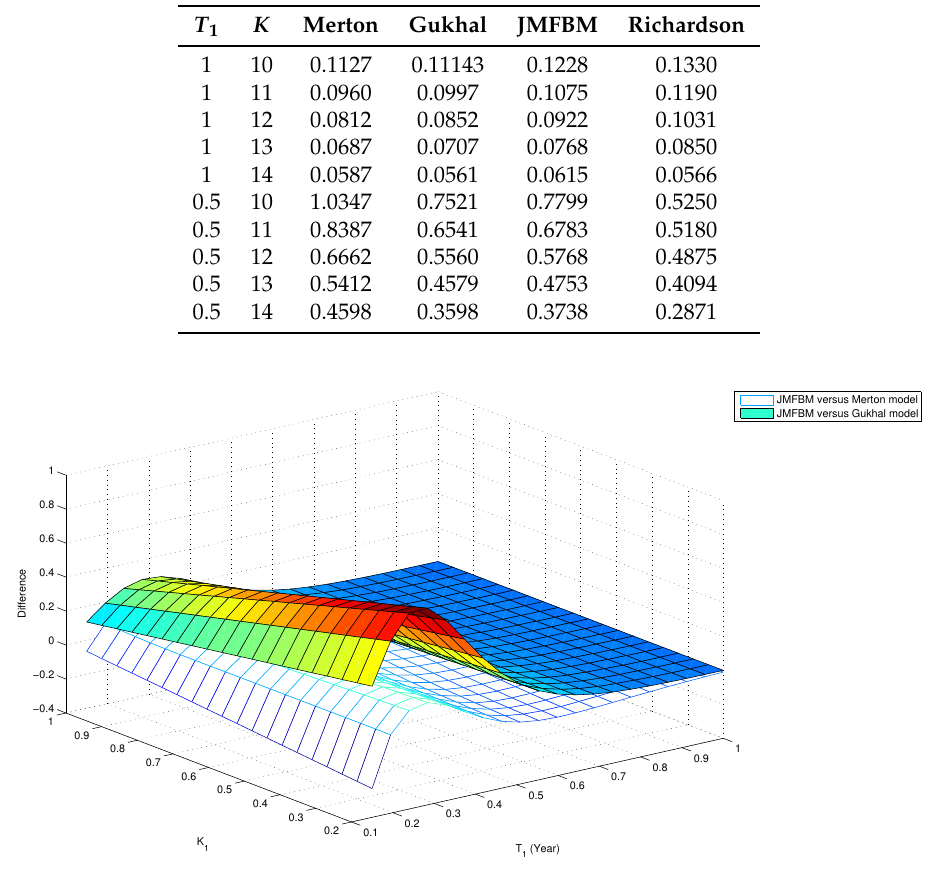
Figure 1. The relative difference between our JMFBM , Guukhal, and Merton models. Parameters fixed are r = 0.3, σ = 0.4, L = 0.1, M = 1.5, A = 0.02, H = 0.8, S = 1.2, σ J = 0.05, k = 0.4 and t = 0.1.